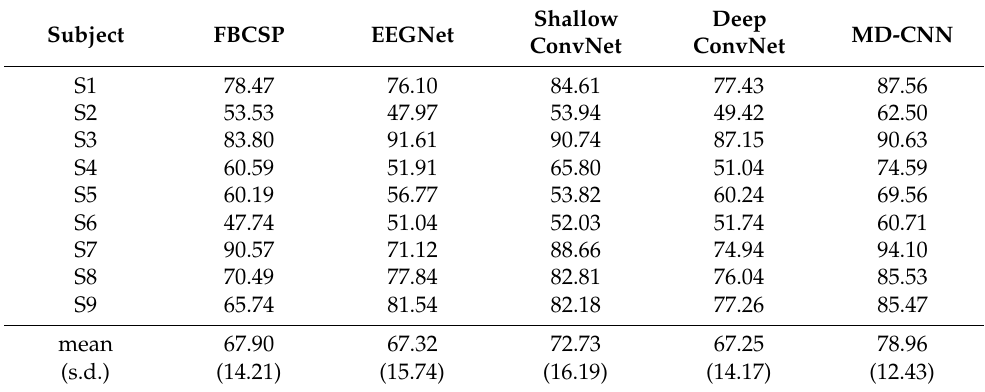
Table 1. Classification accuracy of FBCSP, EEGNet, ShallowConvNet, DeepConvNet, and MD-CNN for the BCI Competition IV dataset